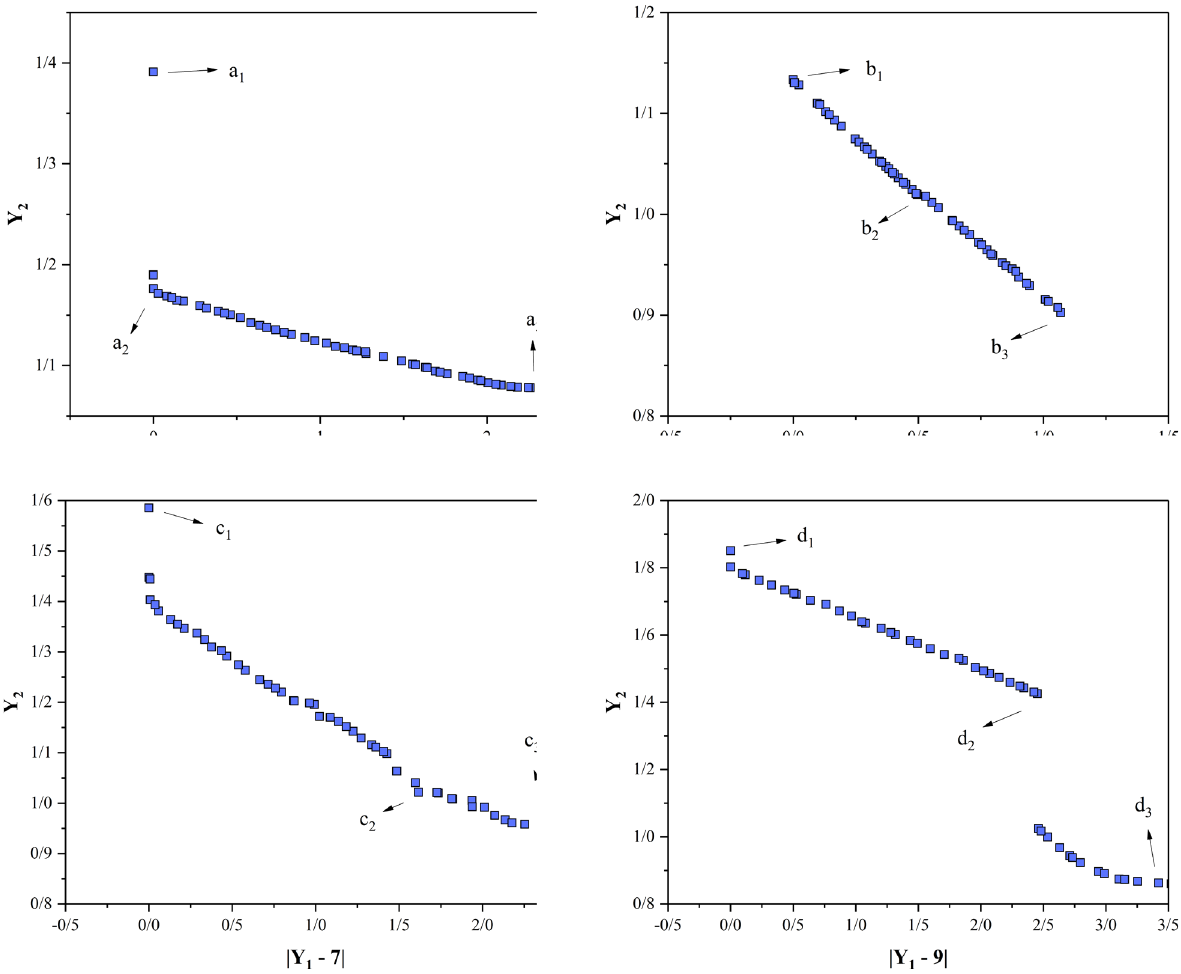
Figure 10: Pareto optimal front for minimizing PSD (Y2) and obtaining different amounts (3, 5, 7, and 9 μm) of PS (Y1) (specified points are introduced in supporting